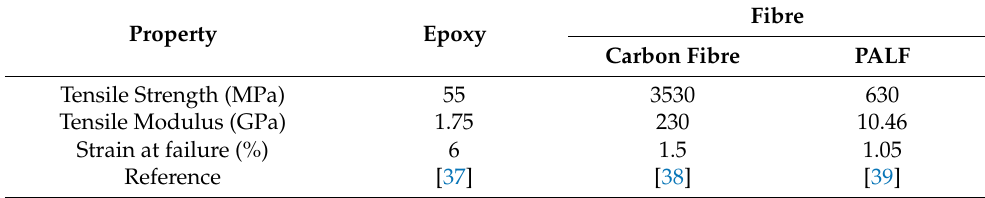
Table 1. Fibres and matrix polymer